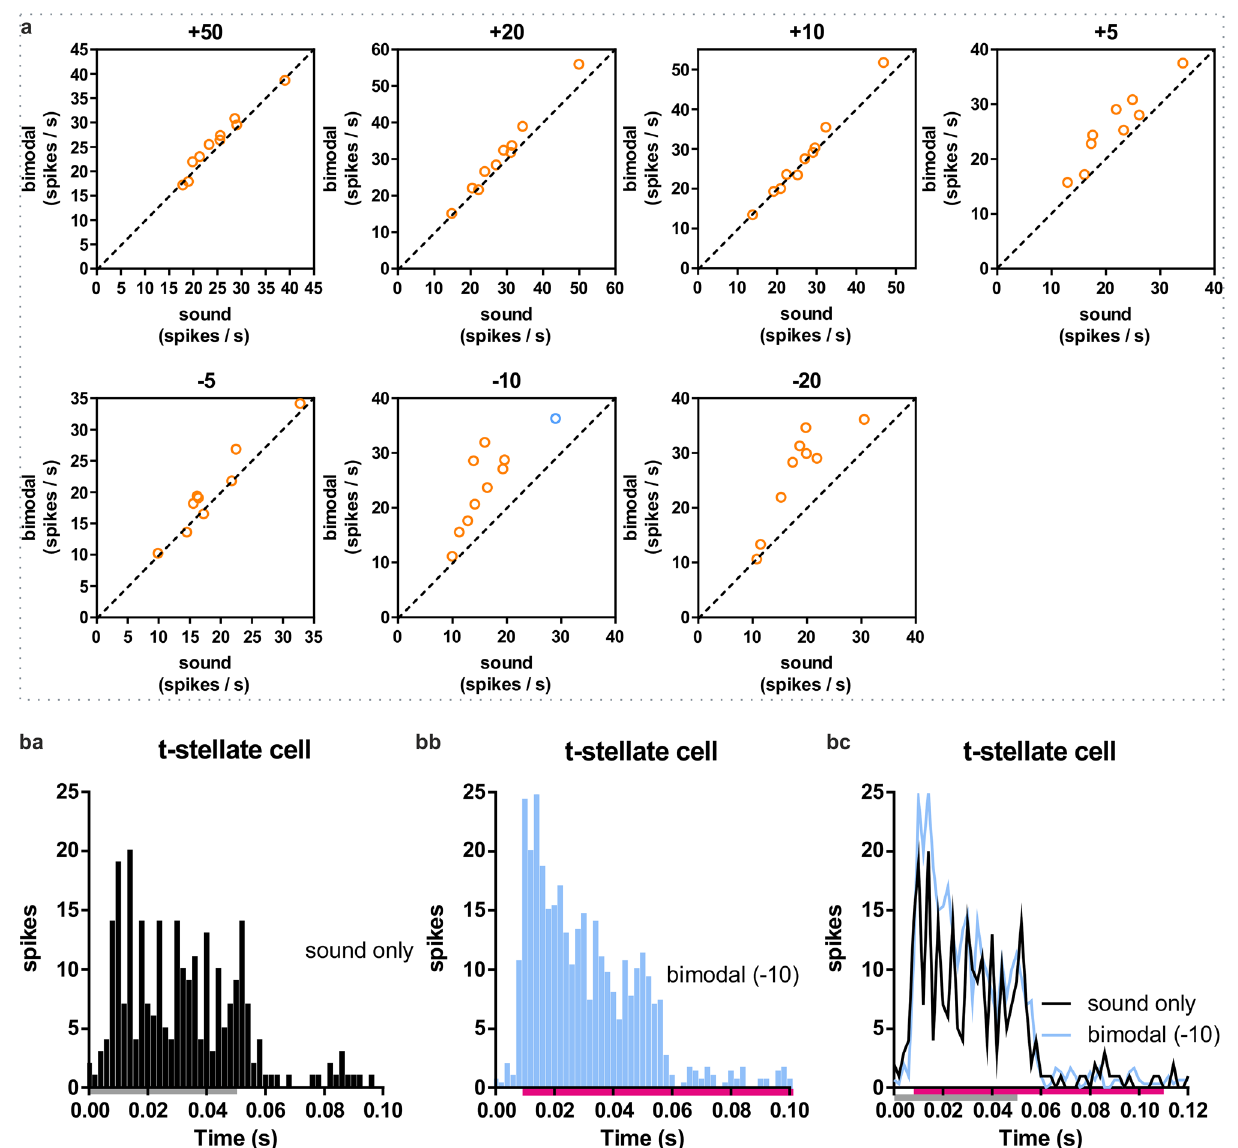
Figure 5. Bimodal response in t-stellate cells in VCN. ( a ) Bimodal compared to only sound stimulation. Each of the protocols (+ 50, + 20 etc.) plotted separately. Each dot is one spike-sorted unit. The dotted line represents a linear regression line with slope 1 (y = x). Blue circle is the example cells from ba-bc . ( ba-bc ) The PSTH of a representative cell is plotted for the − 10 protocol (blue dot in the panel “−10”). ( ba ) The PSTH for only sound. ( bb ) The PSTH for the bimodal stimulation. ( bc ) The overlay of the PSTHs from ba and bb . The grey bar shows the duration of the sound stimulation and the pink bar the duration of whisker stimulation. Sum of 500 stimulations each for sound and